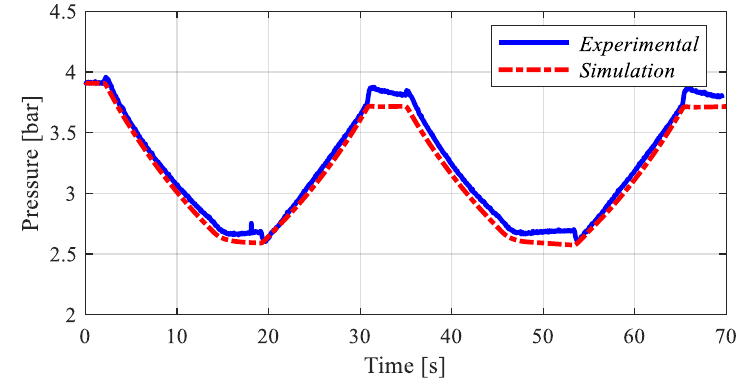
Figure 8. Accumulator line pressure.